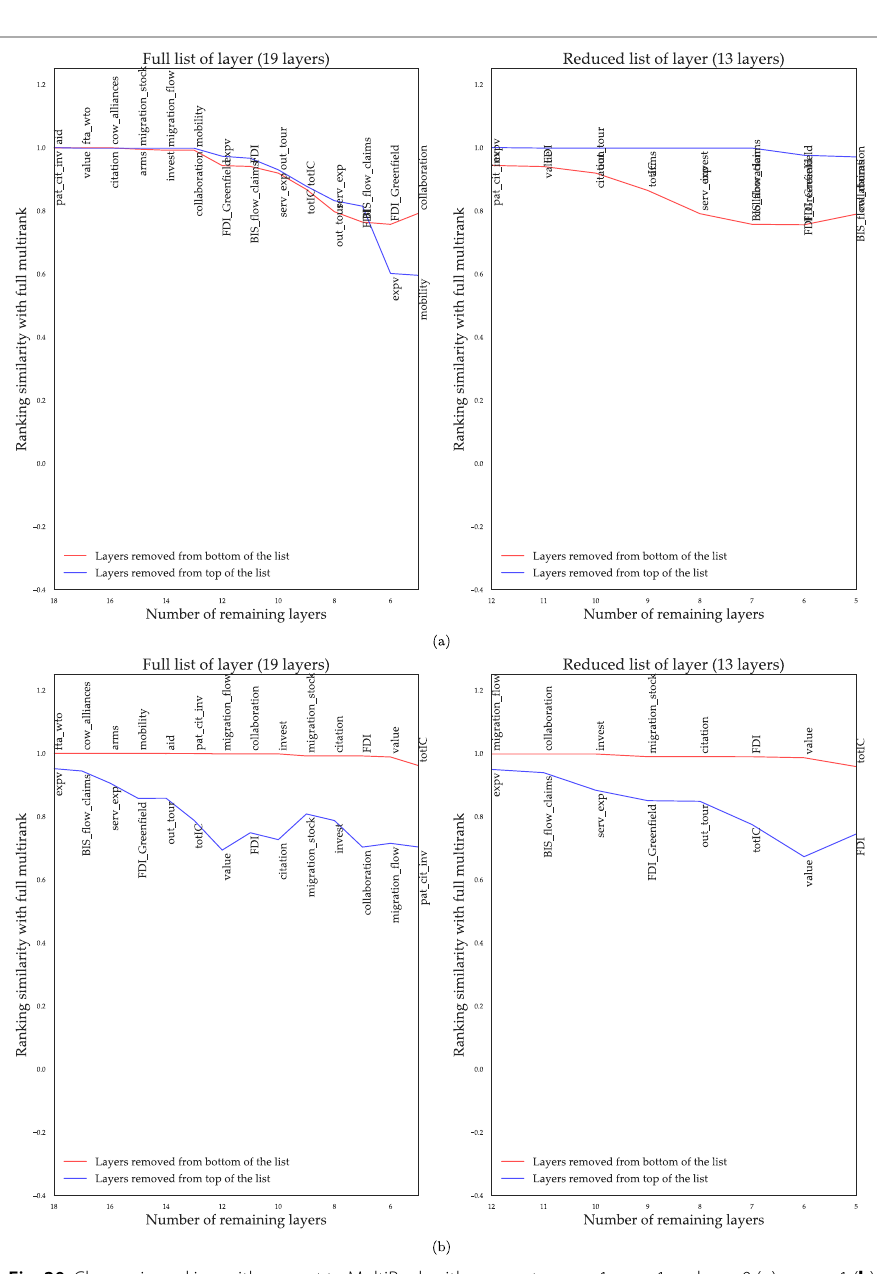
data. However we do not aim to completely reconstruct the ranking of nodes by pcGDP, otherwise our measures will not have an informative